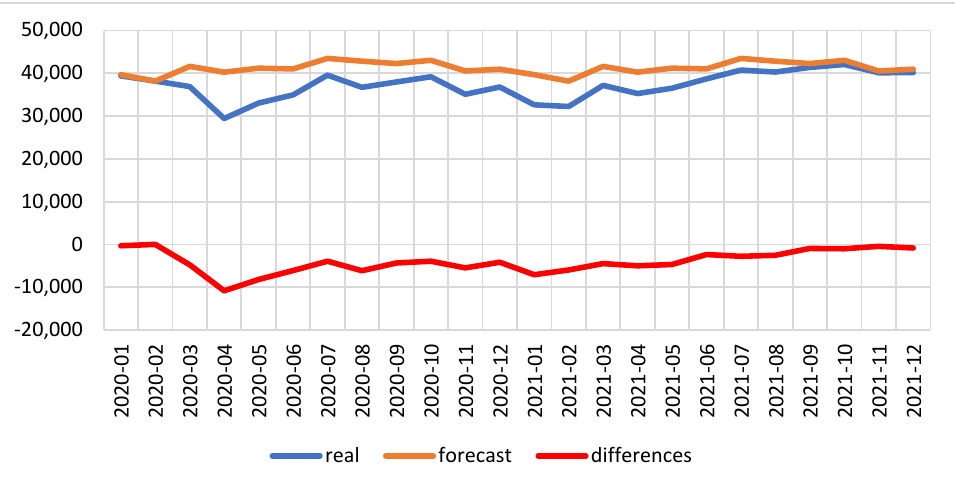
Figure 13. Comparison of the actual and forecast volumes of supplied oil products (in thousand tonnes). Source: own elaboration.